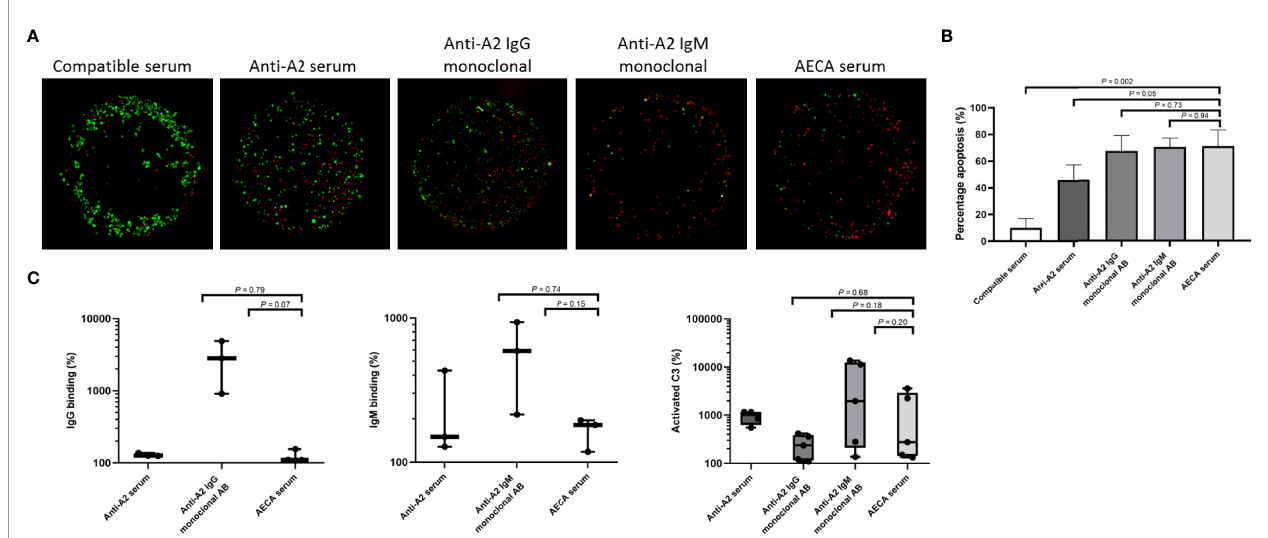
FIGURE 6 | Complement-dependent endothelial cytotoxicity and fl ow crossmatch assays using machine perfusion-derived primary renal endothelial cells (MP- PRECs) and post-transplant patient serum. (A) A representative experiment of a complement-dependent endothelial cytotoxicity crossmatch assay (CDC) using MP- PRECs (HLA typing A2, B62, B60, Bw6, Bw6, Cw10, DR1, DR4, DR53, DQ7, DQ5, and bloodgroup A, incubated with blood group-compatible serum, blood group- and HLA-incompatible serum (anti-A2 serum), a monoclonal antibody directed against A2 IgG, a monoclonal antibody directed against A2 IgM, and the AECA-positive patient serum. Rabbit complement was used as the complement source. Living cells are depicted in green and apoptotic cells in red. (B) Quanti fi cation of n = 3 experiments of apoptotic (red) cells. p- values are depicted in the fi gure. (C) Flow cytometry showing IgG, IgM, and activated C3 binding in percentages after incubation of MP-PRECs with blood group- and HLA-compatible serum, blood group- and HLA-incompatible serum (anti-A2 serum), a monoclonal antibody directed against A2 IgG, a monoclonal antibody directed against A2 IgM, and the patients ’ serum having AECA. A total of 20% human serum was used as the complement source. MP-PRECs that were propidium iodide negative were included in the analysis, indicating living cells. p- values are depicted in the fi gure. Experiments with a positive result for IgG, IgM, and activated C3 binding after incubation with anti-A2 serum were included in the analysis. Data are normalized to the negative control (blood group- and HLA-compatible serum) and are presented on a logarithmic scale. p -values depict results using the unpaired t - t est. Dots represent individual